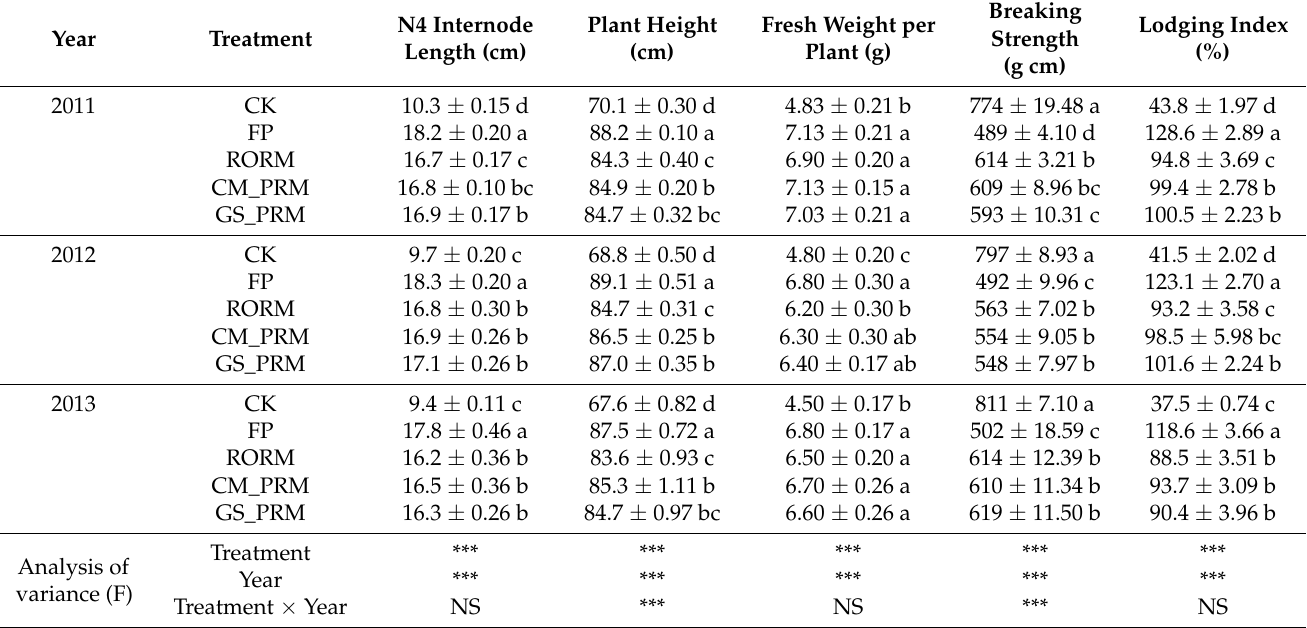
Table 3. Lodging resistance parameters (average values ± standard deviations) of different rice management systems for rice variety Kongyu 131 from 2011 to